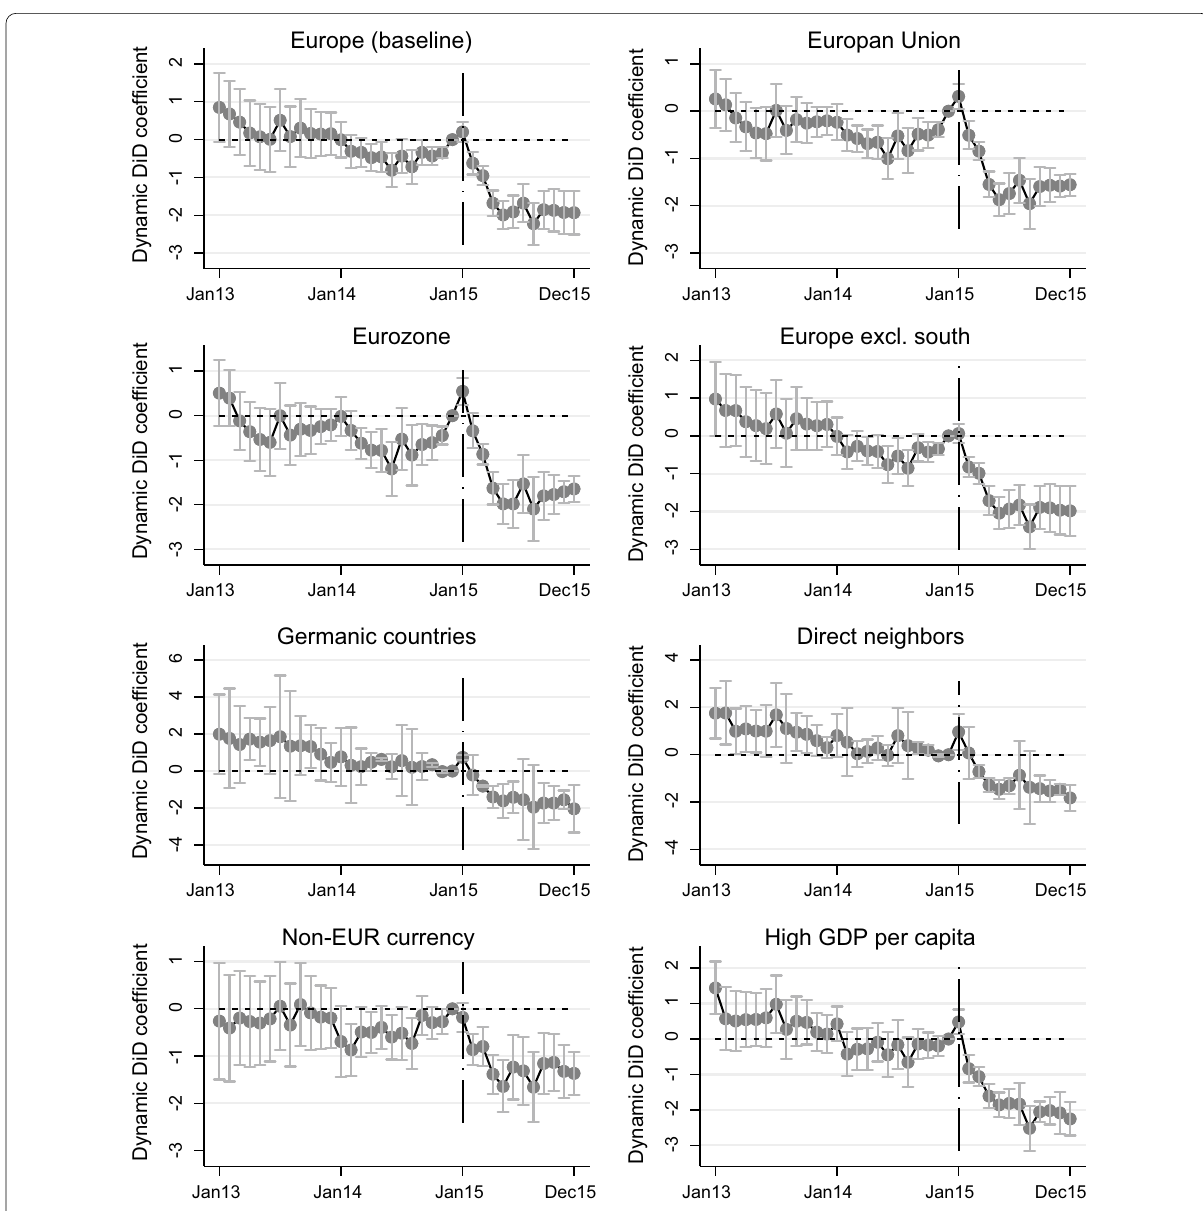
Fig. 8 All-items dynamic DID coefficients for alternative control groups. Notes: DID regression with dynamic lags/leads, as well as country and time fixed effects, following regression 2. Standard errors are clustered at the country level. Coefficients are computed from the HICP monthly all-items consumer price index from January 2013 to December 2015, using post-January 2015 Switzerland as a treatment. The alternative treatment groups are detailed in Table 1. Bands show the 95% confidence interval for each